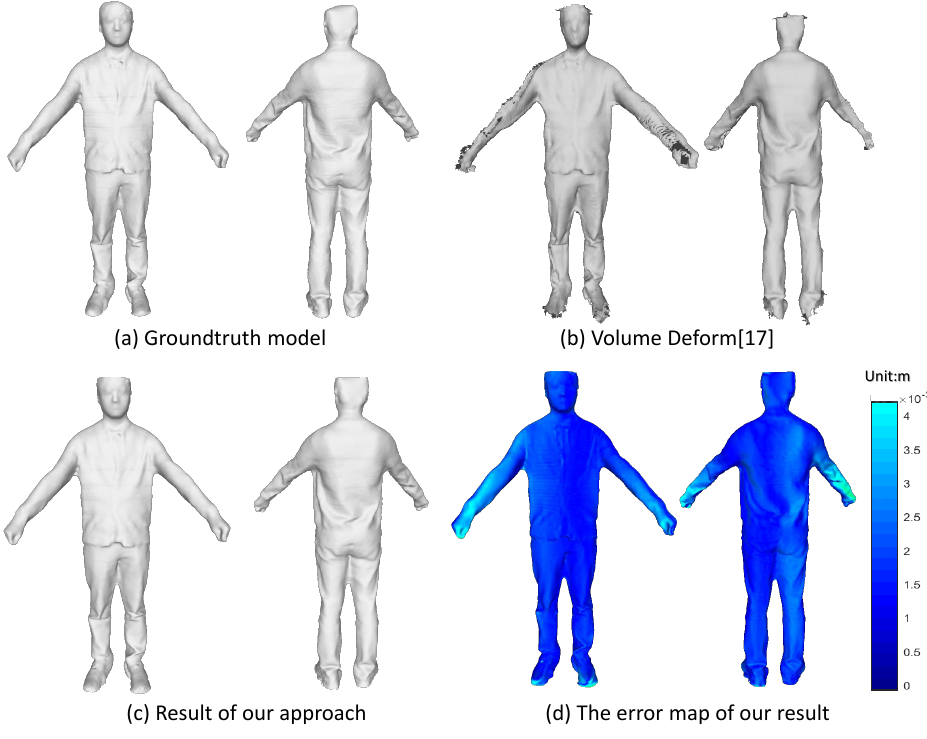
Figure 9. Quantitative evaluation on synthetic